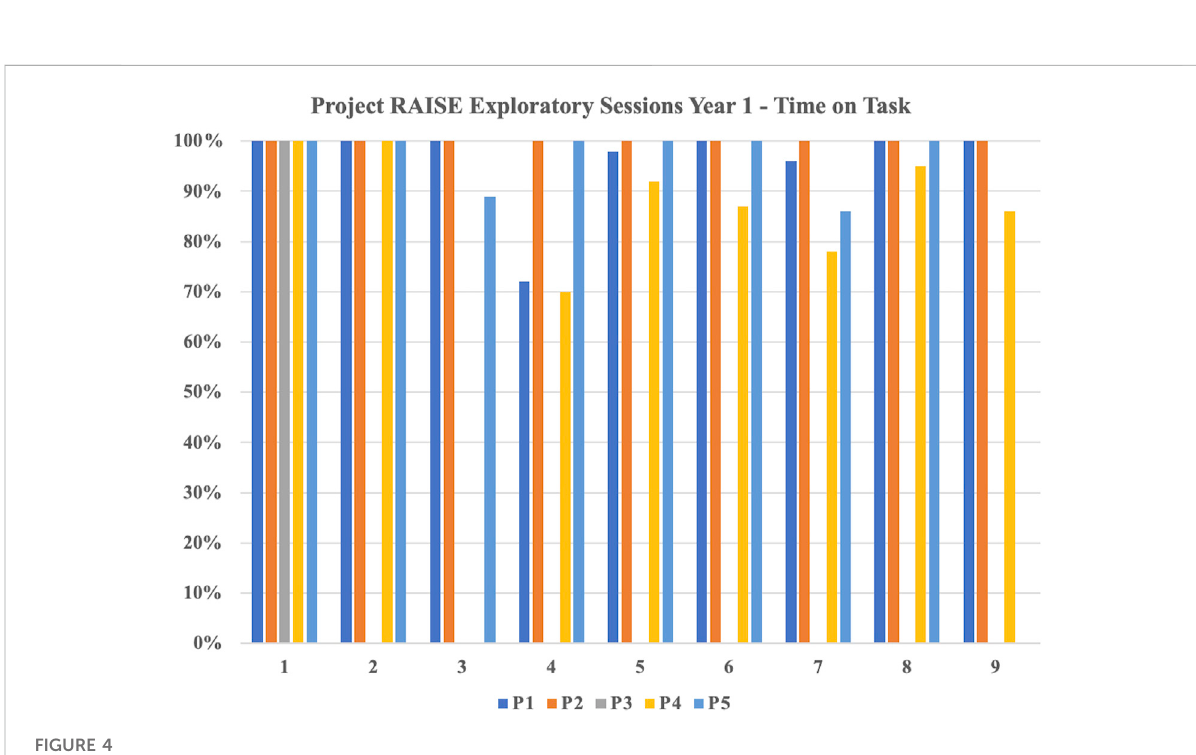
FIGURE 4 Time on task during year